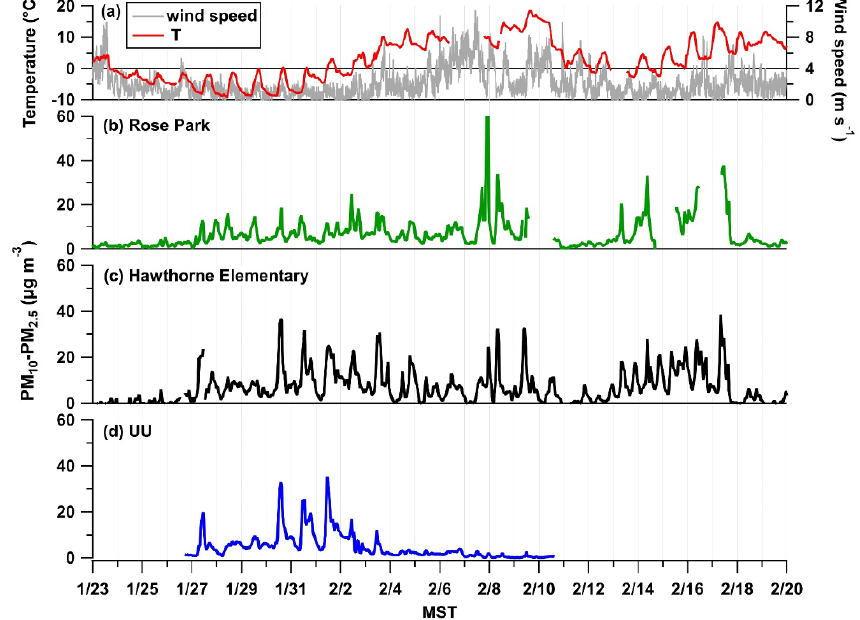
Figure 4. (a) Wind speed and temperature ( ◦ C) measured at UU. The coarse particle (PM 10 –PM 2 . 5 ) mass loading in µgm − 3 as a function of time, 28 January to 4 February 2017, at three separate ground-based sites: Rose Park (b) shown in green and Hawthorne Elementary (c) shown in black, which are EPA monitoring sites, and the UU site (d) in